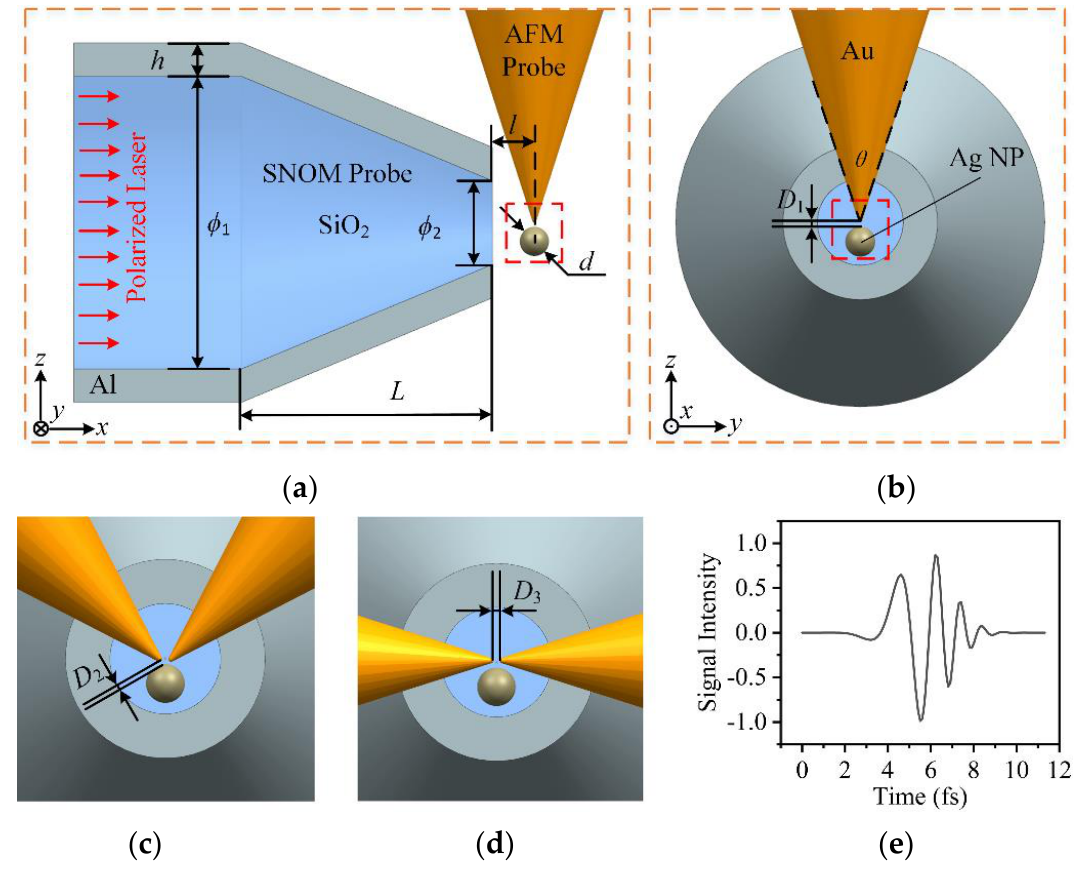
Figure 1. Configurations of single probe and dual probe irradiated by polarized near-field laser coming from a SNOM probe. Front view ( a ) and slide view ( b ) of single probe; Dual probes with axis angles 90° ( c ) and 180° ( d ); ( e ) Time signal of normalized laser.